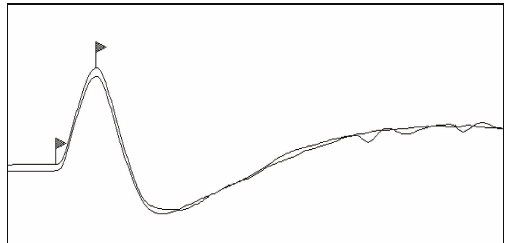
Figure 5: CDP of the left tibial nerve of ferret N.6. Left flag indicates the onset; right flag indicates the peak of the potential. 2 ms/Div; 5 μ